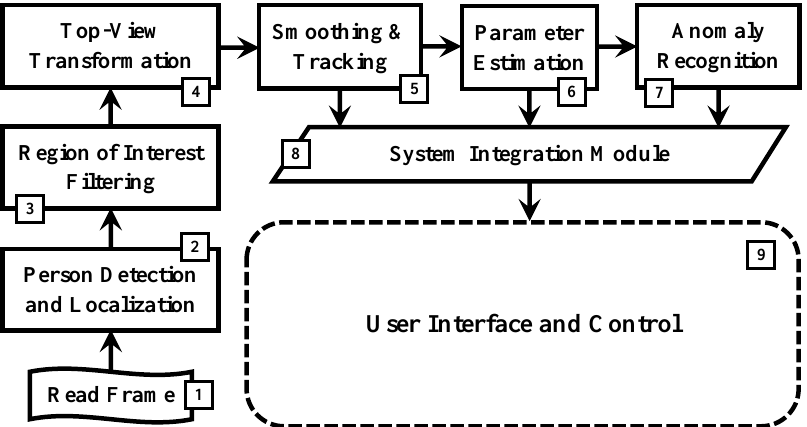
Figure 1. The proposed social distance estimation and crowd monitoring system model. The model is comprised of the following stages: (1) Read a video frame; (2) Detect human subjects and localize their positions; (3) Discard all positions outside the ROI; (4) Transform the remaining positions to the real-world coordinates; (5) Smooth the noisy estimates and compensate for missing data by tracking; (6) Estimate the subjects’ inter-personal distances and crowd density maps; (7) Recognize irregularities in the crowd state in terms of social distance infringements and congestion; (8) Integrate the video frame with the estimated parameters and identified anomalies; and (9) Display the integrated frame and generate a dynamic top-view map for the